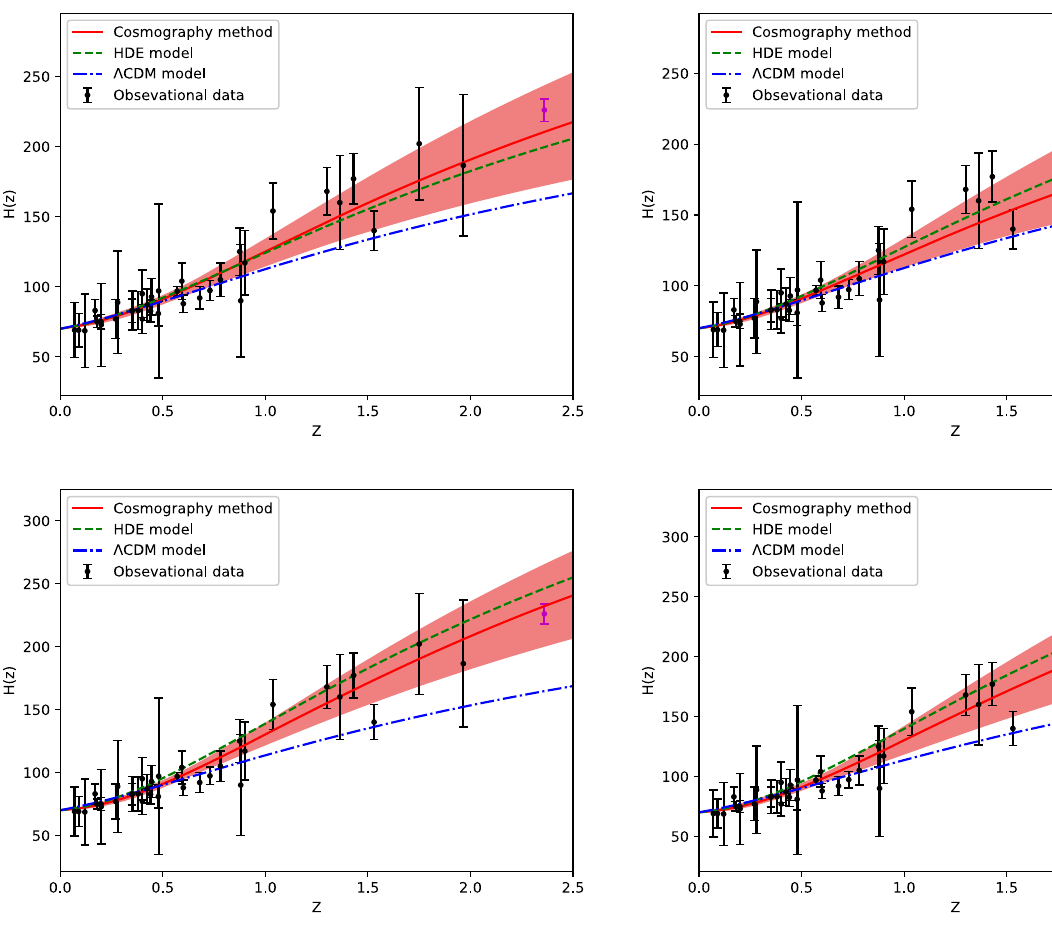
model-independent method. The upper left (upper right) panel shows resultsobtainedusingthePantheon(Pantheon+GRB)sample.Thebot- tom left (bottom right) panel shows results obtained using the Pantheon + quasars (Pantheon + GRB + quasars)